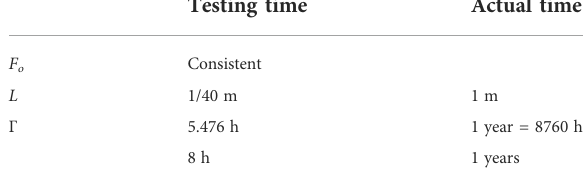
TABLE 3 Test time simulation time